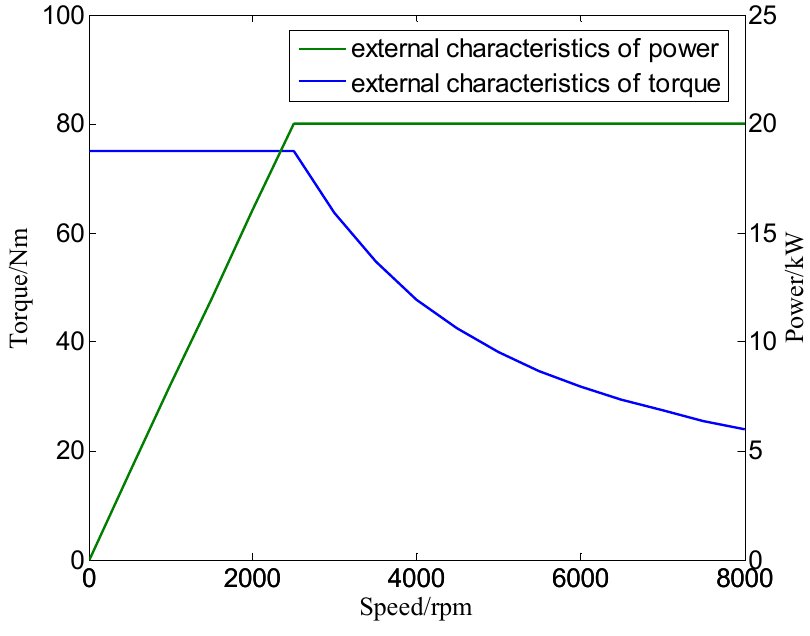
Figure 3. Motor power/moment external